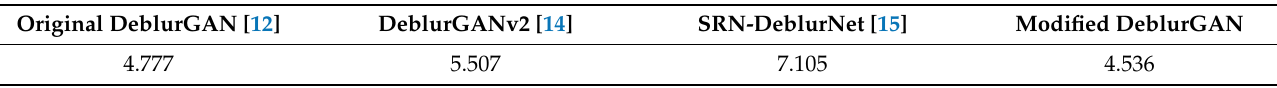
Table 12. Comparisons of finger-vein recognition error (EER) by using the state-of-the-art restoration models and proposed methods with PolyU-DB (unit: